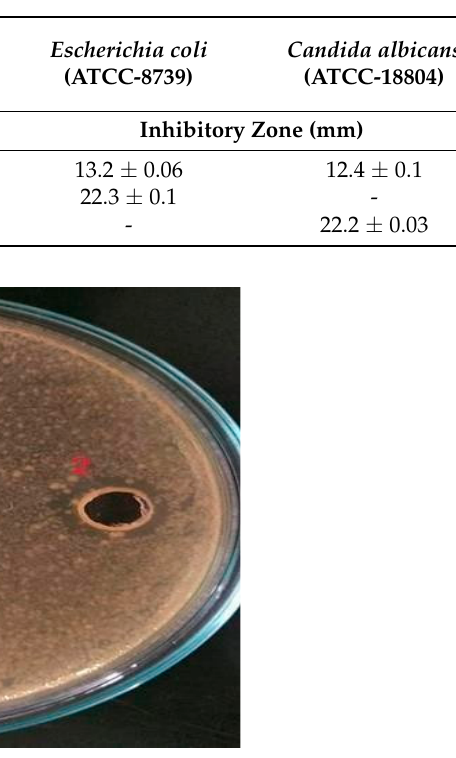
Figure 1. Zone of inhibition of Vigna radiata extract towards Staphylococcus aureus ( 1 ) 12.4 mm, ( 2 ) 12.3 mm, ( 3 ) 12.1 mm and ( c ) control.